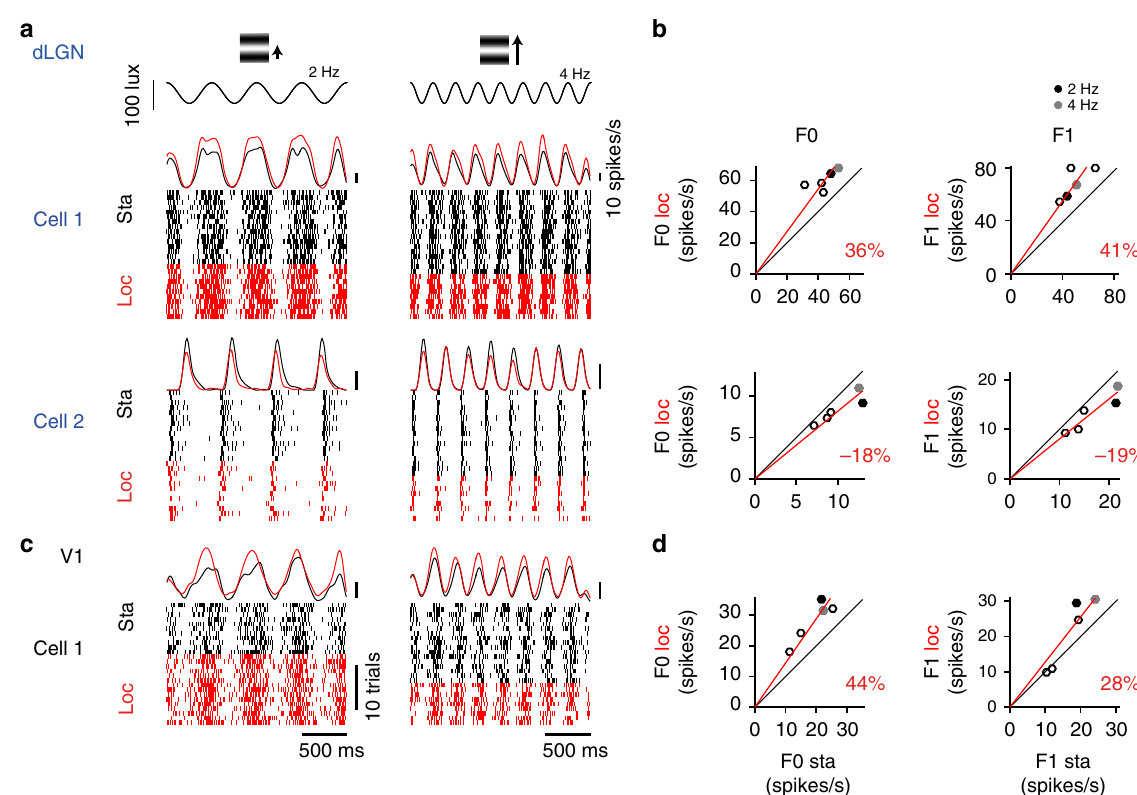
Fig. 2 Locomotion related modulations of early visual responses. a Peri-stimulus time spike raster plots and histograms for two dLGN neurons in response to full fi eld drifting gratings stimuli (temporal frequency: 2 Hz, left; 4 Hz, right). Responses in locomotion (red) and stationary (black) trials are plotted separately. Scale bars, 10 spikes/s and 10 trials. b Mean fi ring rate (F0) and response (F1) amplitude in stationary vs. locomotion epochs trials for the cells in ( a ) (36% increase and 18% decrease in fi ring rate; 41% increase and 19% decrease in response amplitude). c Spike raster plot and histogram for a V1 cell. d Same for a V1 cell (44% increase in fi ring rate; 28% increase in response